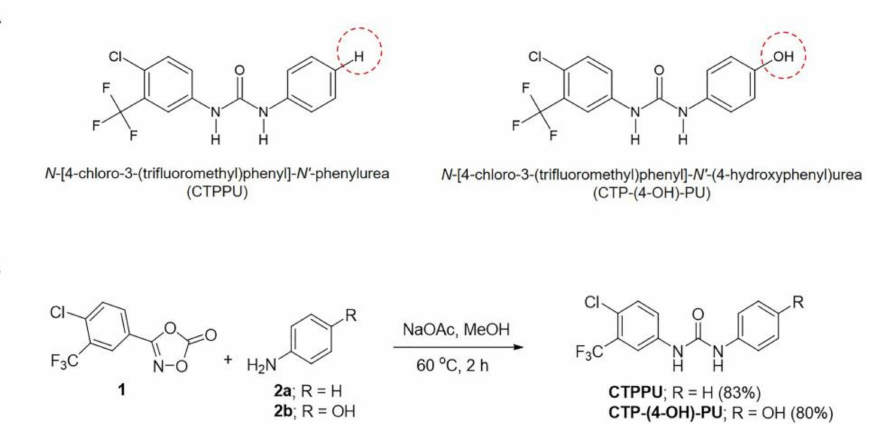
Figure 1. Chemical structure of N,N (cid:48) -substituted phenylurea derivatives and synthesis. ( A ) Structure of CTPPU (left) and CTP-(4-OH)-PU (right). ( B ) Synthetic scheme of N,N (cid:48) -substituted phenylurea derivatives (CTPPU and CTP-(4-OH)-PU) and their yield